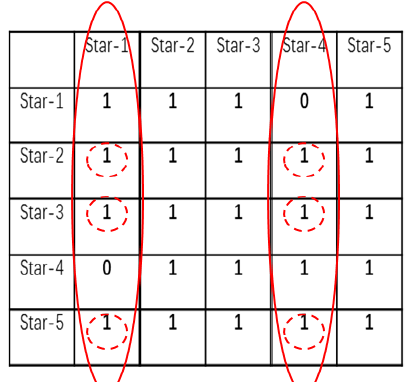
Figure 10. Extend the core cluster.